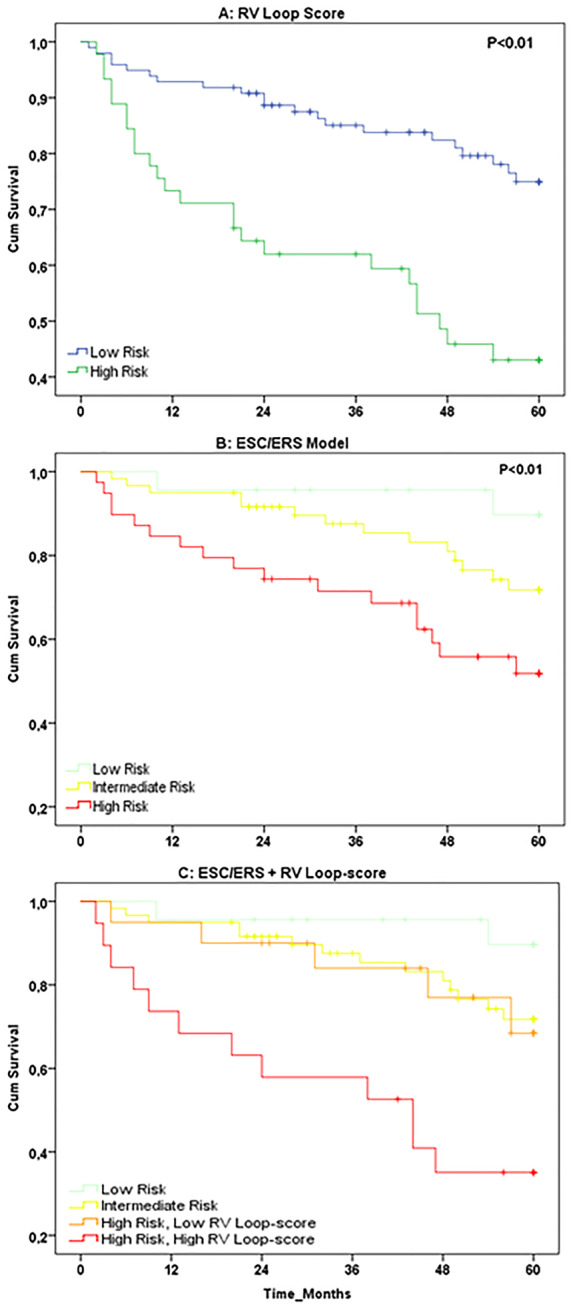
Kaplan–Meier survival curves for (A) the RV loop-score, categorised into low risk (blue line, n = 98) vs. high risk (green line, n = 45), (B) the 2015 ESC/ERS guidelines based model, categorised into low (green line, n = 23), intermediate (yellow line, n = 60), and high risk (red line, n = 39), and (C) the combined RV loop-score and ESC/ERS based model, categorized into low risk (green line, n = 23), intermediate risk (yellow line, n = 60), high risk—low RV loop-score (orange line, n = 20), and high risk—high RV loop-score (red line, n = 19).